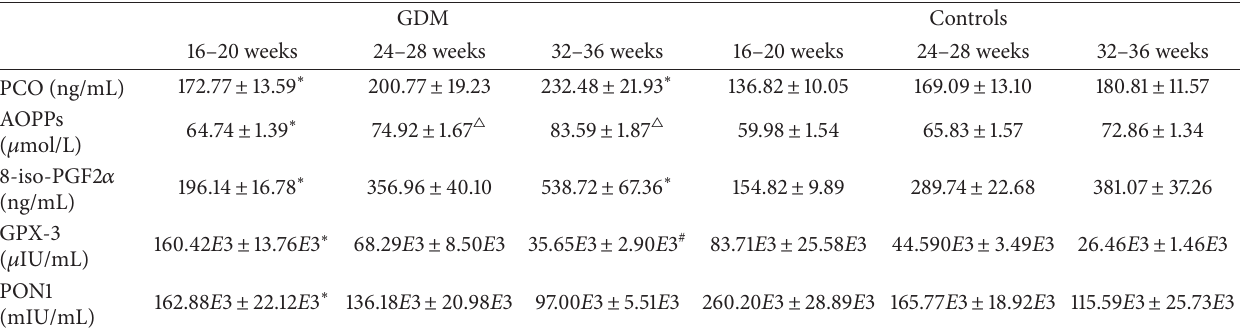
Table 2: Markers of oxidative stress and antioxidants in women with GDM and without GDM